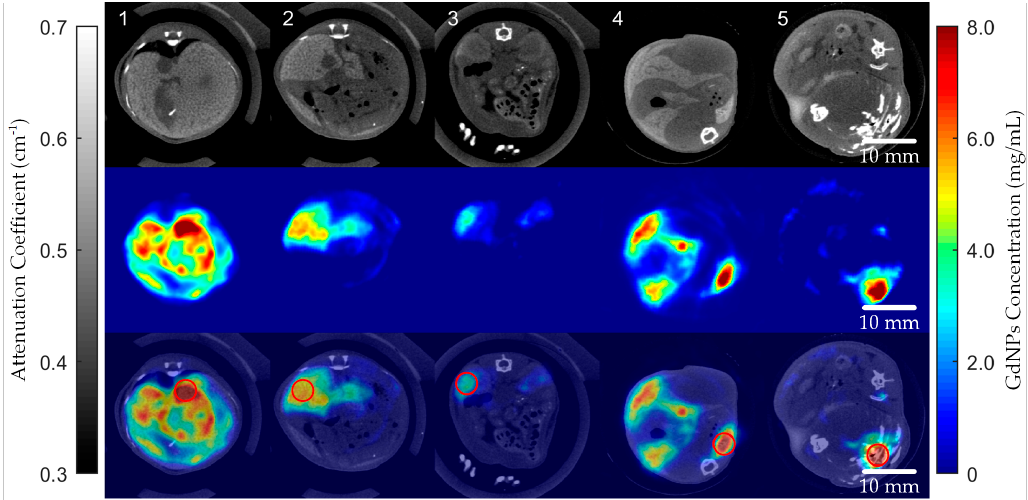
Figure 5. Transmission CT images, XFCT images and CT and XFCT fused images of the 5 target slices. The red circles denote the sampling points of the target regions.